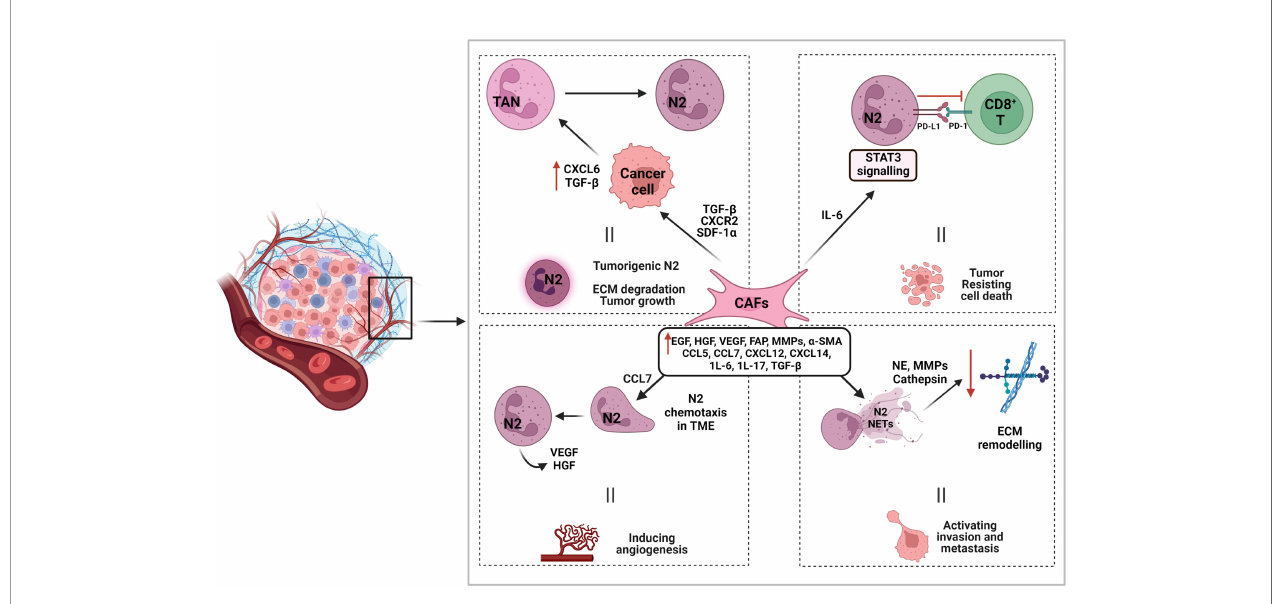
FIGURE 4 | Interaction of cancer-associated fi broblasts in promoting N2 function and tumorigenesis. Cancer-associated fi broblasts (CAFs) induce tumorigenic N2 by various interactions. CAF associated molecules such as TGF- b , CXCR2, and SDF-1 a , promote cancer cell expression of CXCL6 and TGF- b , which aid in N2 polarization and TME recruitment. CAF produced IL-6 induces STAT3 signaling pathways that modulates PD-L1/PD-1 interaction between N2 and CD8 + T cells and aids in tumor cell death resistance. CAF associated chemokine CCL7 also aids in N2 recruitment to TME by chemotaxis. Other CAF associated molecules contribute to N2 NETosis and the production of proteases such as NE, MMPs, and cathepsin to degrade and remodel ECM and promote tumor invasion and